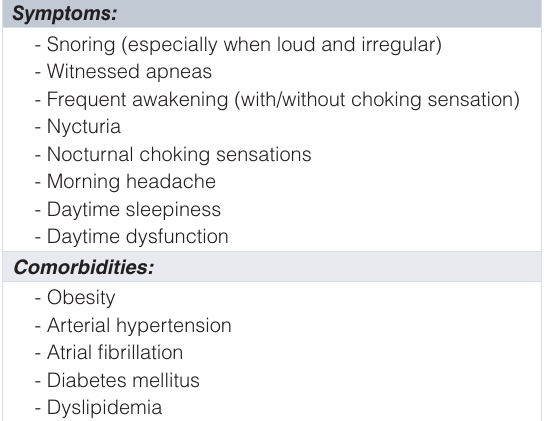
Table 3. Symptoms and comorbidities of sleep apnea.